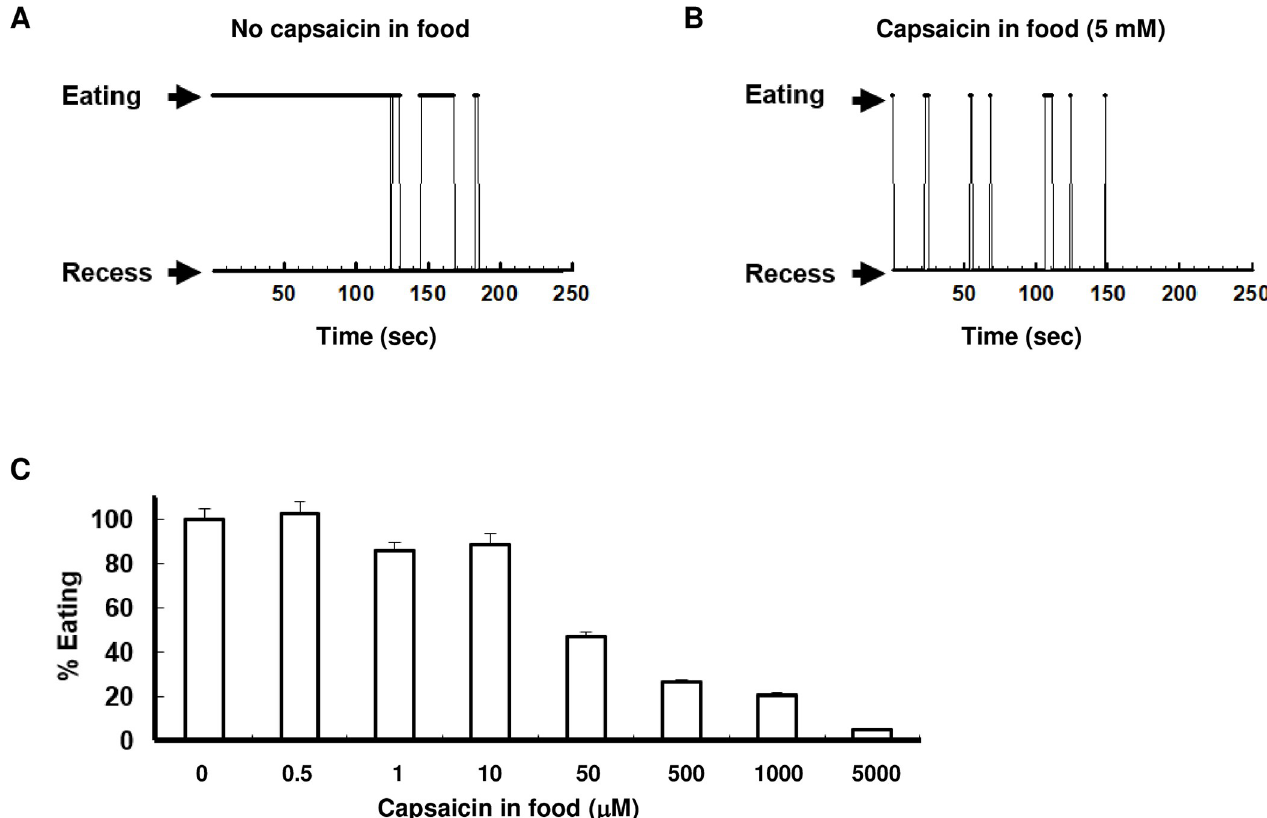
Fig 1. md-TRPV1(3) flies are aversive to capsaicin ingestion. (A, B) Hungry (18 hours starved on water-soaked filters) md-TRPV1(3) flies were offered either normal food (A) or capsaicin-containing food (B). Those provided normal food continuously sipped for longer than three minutes before idling, whereas flies given 5 mM capsaicin-containing food exhibited repeated brief sipping (~ one second) and longer recess intervals. (C) The sipping period of hungry md- TRPV1(3) flies on capsaicin food is dependent on capsaicin concentration. Values are the average of eating intervals measured for 2 minutes beginning immediately after flies were transferred to food containing varying amounts of capsaicin (0 to 5 mM). Bars represent mean ± SD. n = 10 for each capsaicin concentration. All flies were 5-day-old males. md-TRPV1(3) denotes one copy of md-Gal4 and 3 copies of UAS-TRPV1 .